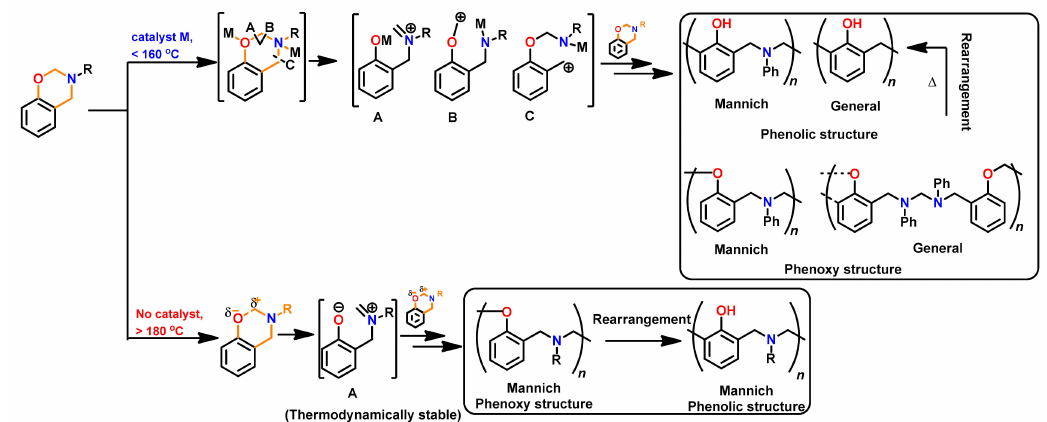
Figure 33. Proposed polymerization mechanism to reflect the effect on structure linkages in PBz with variation in tempera- ture and